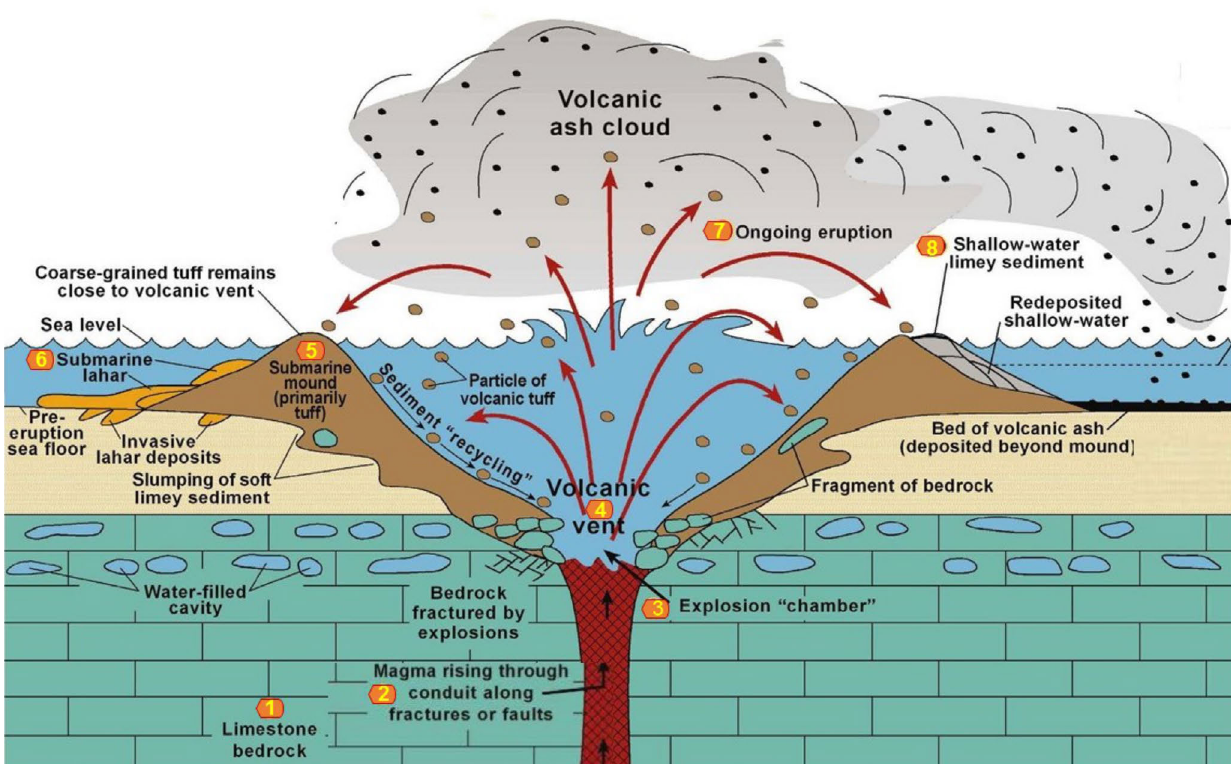
Figure 2: A schematic model of an erupting BMP submarine volcano and its near-vent architecture (modified after Caran et al. [2012]).